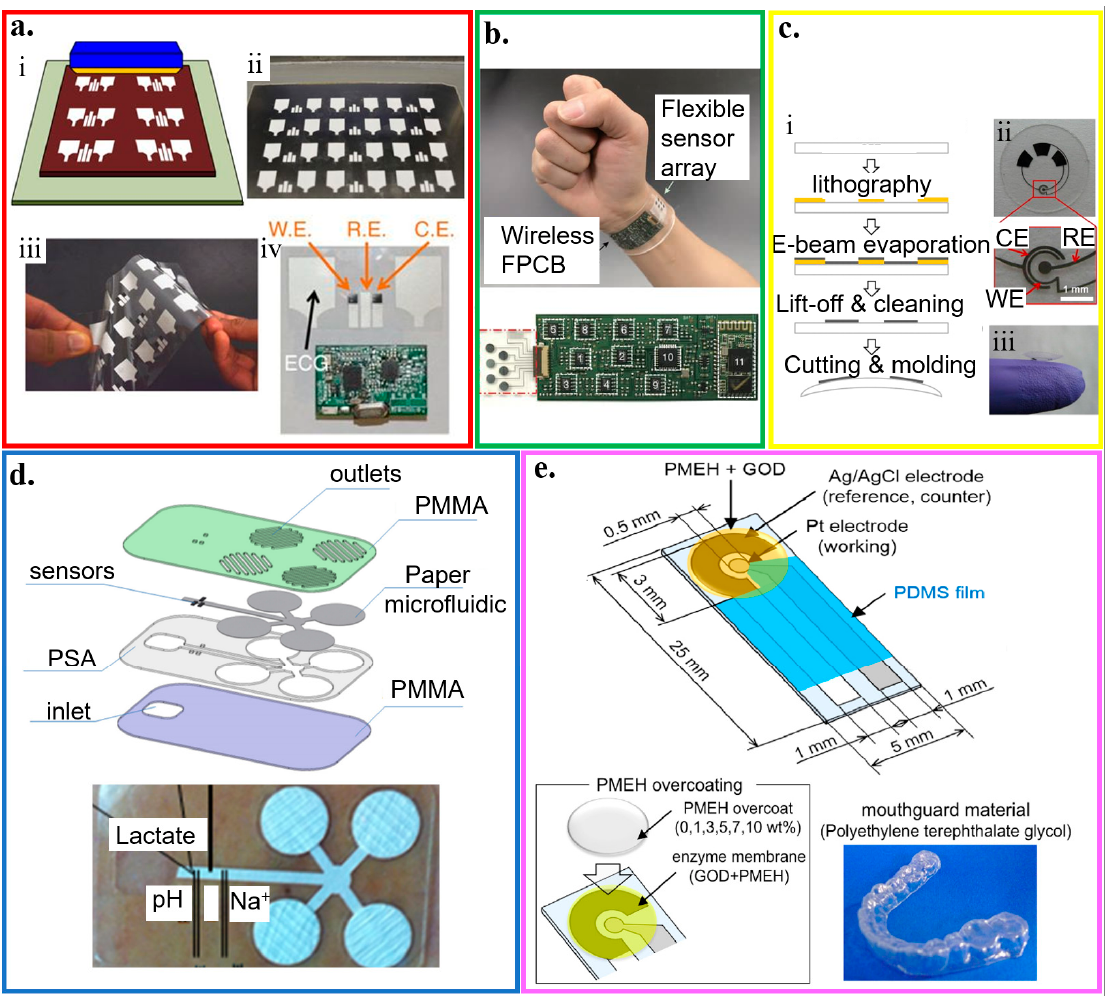
Figure 7. Plastic ‐ based wearable electrochemical biosensors. ( a ) i) Schematic and ii) optical image